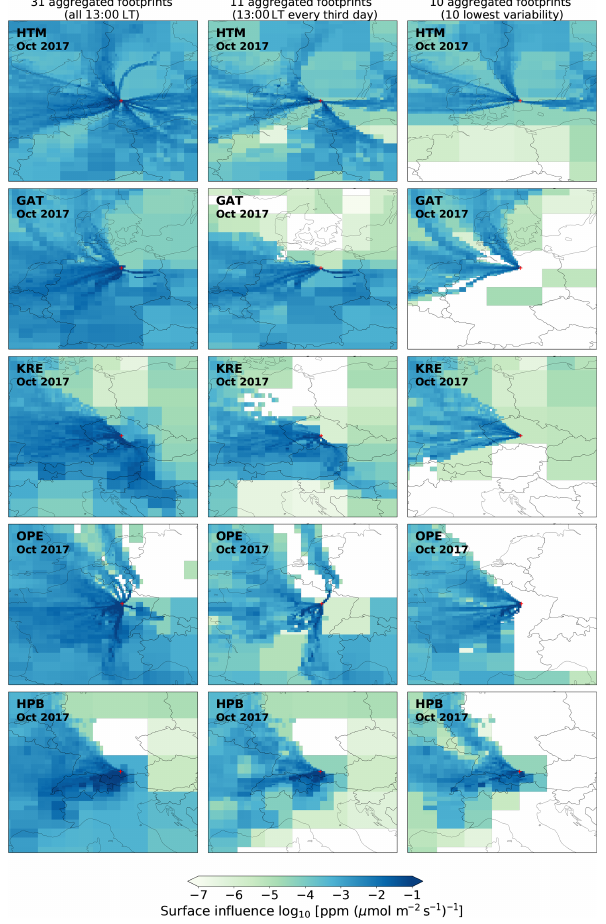
Figure 4. Aggregated footprints calculated for the five ICOS sta- tions from top to bottom: Hyltemossa (HTM), Gartow (GAR), Kˇrešín (KRE), Observatoire Pérenne de l’Environnement (OPE), and Hohenpeißenberg (HPB) for October 2017. The left column shows the footprints for all 31d at 13:00 local time (LT), the mid- dle column shows the same footprints, but sampled only every third day, and the right column shows those of the 10d with the lowest variability. Note the logarithmic colour